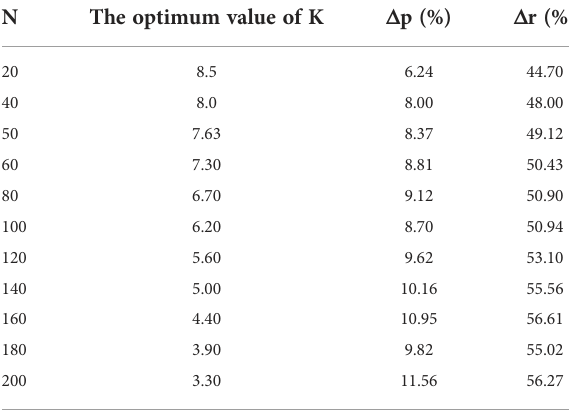
TABLE 5 Evaluation indicators ( p 0 = 0.5, W = 2, and Q is the maximum value). N The optimum value of